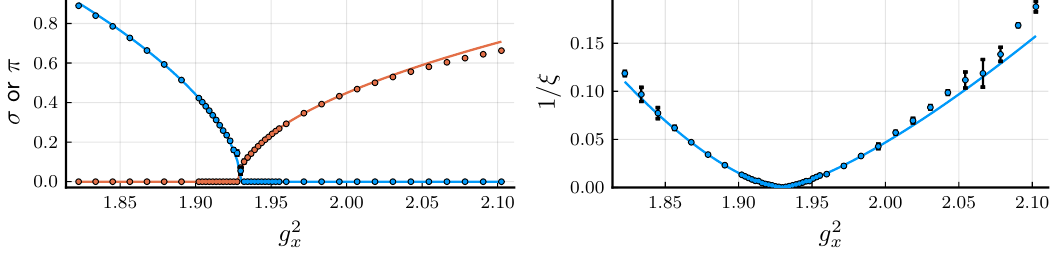
Figure 5 . (Left) The extrapolated order parameters σ and π (plotted in orange and blue respectively) as g 2 and g 2 are tuned to take us trough the transition along g 2 x y The extrapolated inverse correlation length for the same couplings. The highest bond dimensions used for these simulations are of the order 1100 . The continuous lines represent four independent power-law fits to the numerical data (for σ , π , and for both sides of ξ − 1